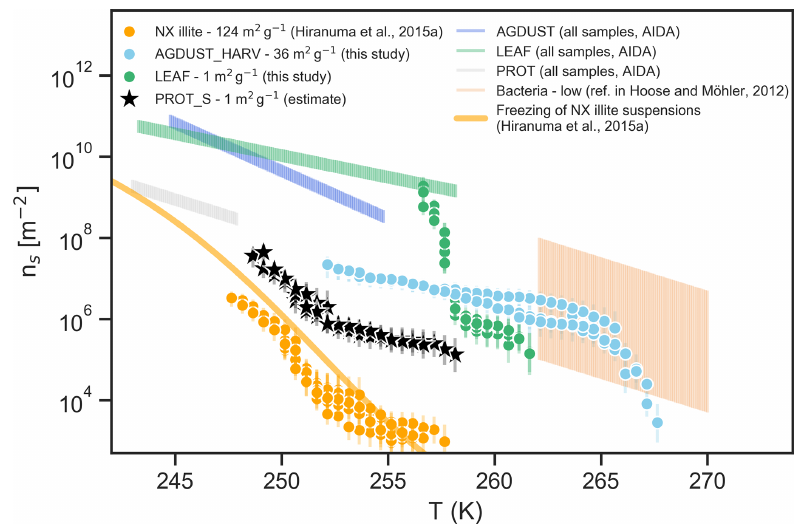
Figure 2. Immersion freezing results for selected plant-related samples and illite by comparing INSEKT-derived INAS density values to results from AIDA experiments (Fig. 1). Ice nucleation efficiency is expressed as INAS density values based on INSEKT droplet freezing experiments and specific surface areas indicated in the